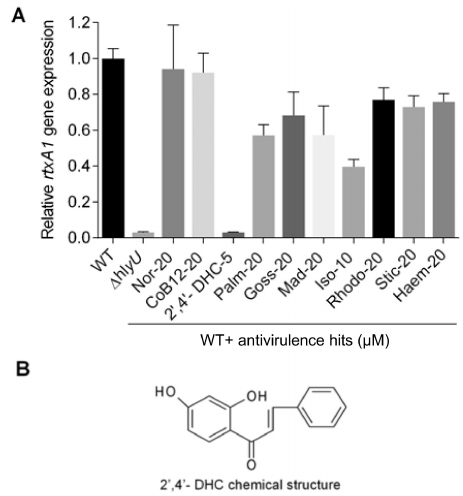
Figure 2. Identification and assessment of antivirulence 2 (cid:48) ,4 (cid:48) - DHC. ( A ) rtxA1 gene expression analysis of 10 secondary antivirulence hits. A fresh culture of wild-type (WT) V. vulnificus was incubated to grow with and without various compounds at the mentioned concentrations ( µ M) until OD 600 1.8–2.0 and total RNA was isolated to prepare cDNA for qRT-PCR analysis. Gene expression level was normalized with the expression level of gyrB. The relative expression level against the non-treated WT control sample is displayed; ( B ) chemical structure of 2 (cid:48) ,4 (cid:48) -DHC